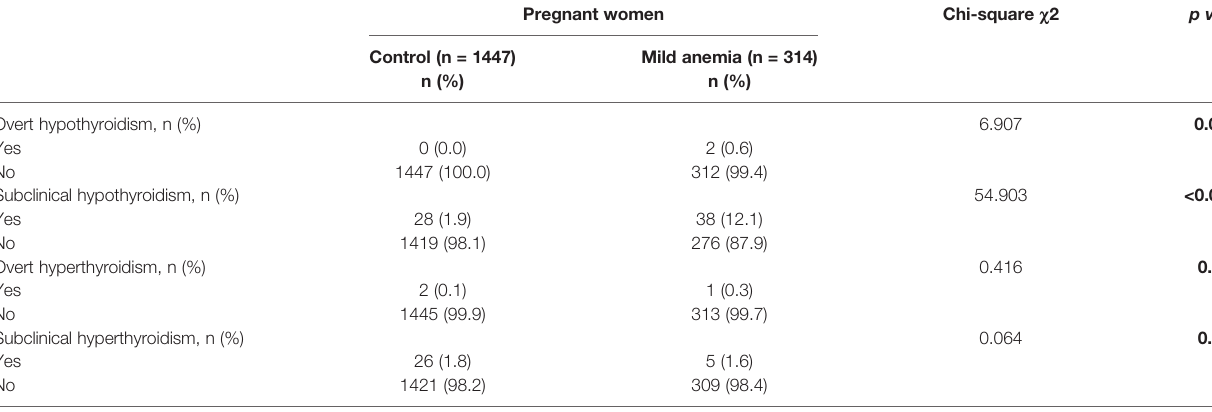
TABLE 4 | Prevalence of thyroid diseases in pregnant women with mild anemia compared to the control group.